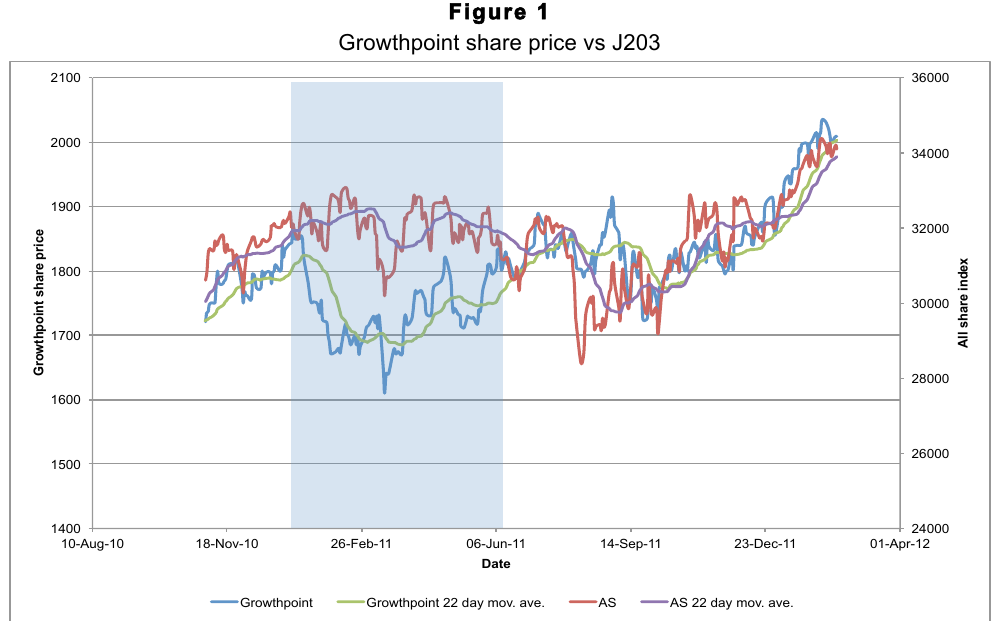
Growthpoint share price vs J203